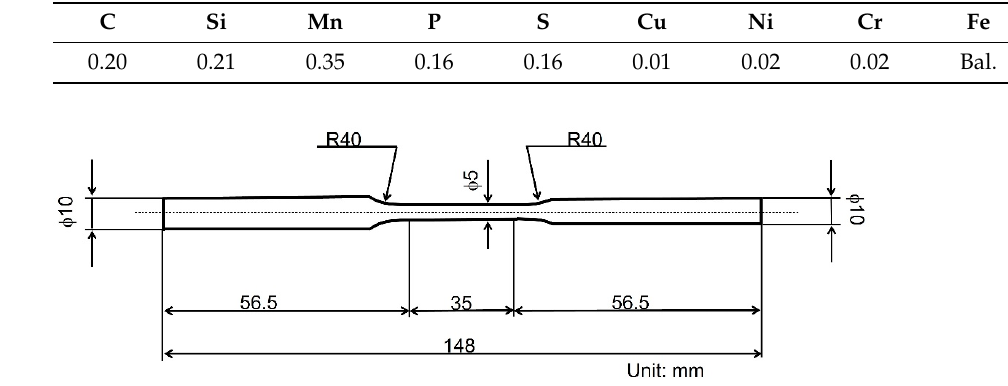
Figure 1. Schematic diagram of the tensile and fatigue test specimens.